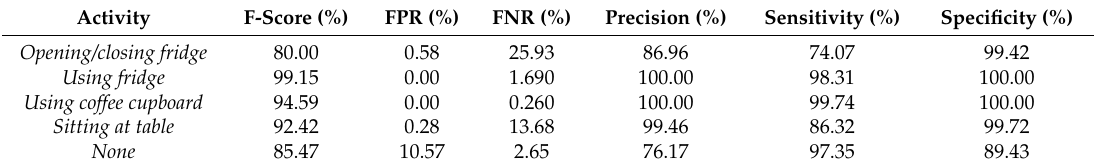
Table 10. Results for the predictions of the inferred activities for all frames captured during the experiment.